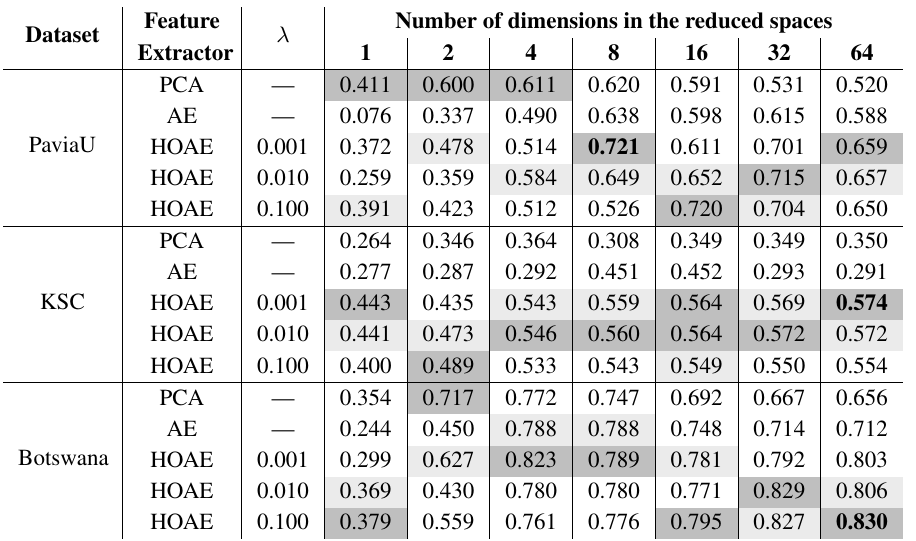
Table 2. Overall accuracy classification performances for the Support Vector Machine classifier in combination with the Principal Component Analysis (PCA), Autoencoder (AE), and Hyperspectral Orthogonal Autoencoder (HOAE) feature extraction techniques. The results correspond to a different number of dimensions in the reduced space and penalization parameter ( λ ) .